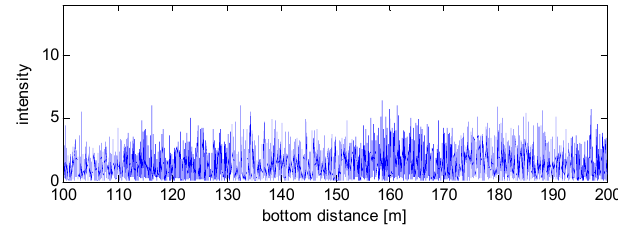
Figure 5. Matched filtering outputs when the time reversal technique is applied to the section where only the seabed scattering exists.